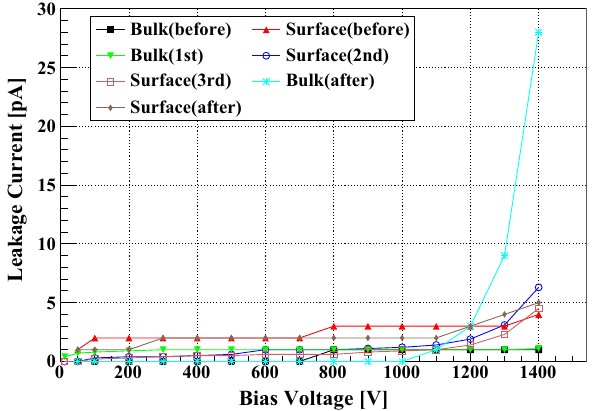
Fig. 11 Leakage currents of detector USD-R02 versus its bias voltage inLN 2 ,exceptforthedatasetsmarkedwith“before”and”after”,which were measured in the vacuum cryostat at USD before and after the MPI deployment. The bulk leakage currents were measured through the centralcontact.Thesurfaceleakagecurrentsweremeasuredthroughthe guard contact